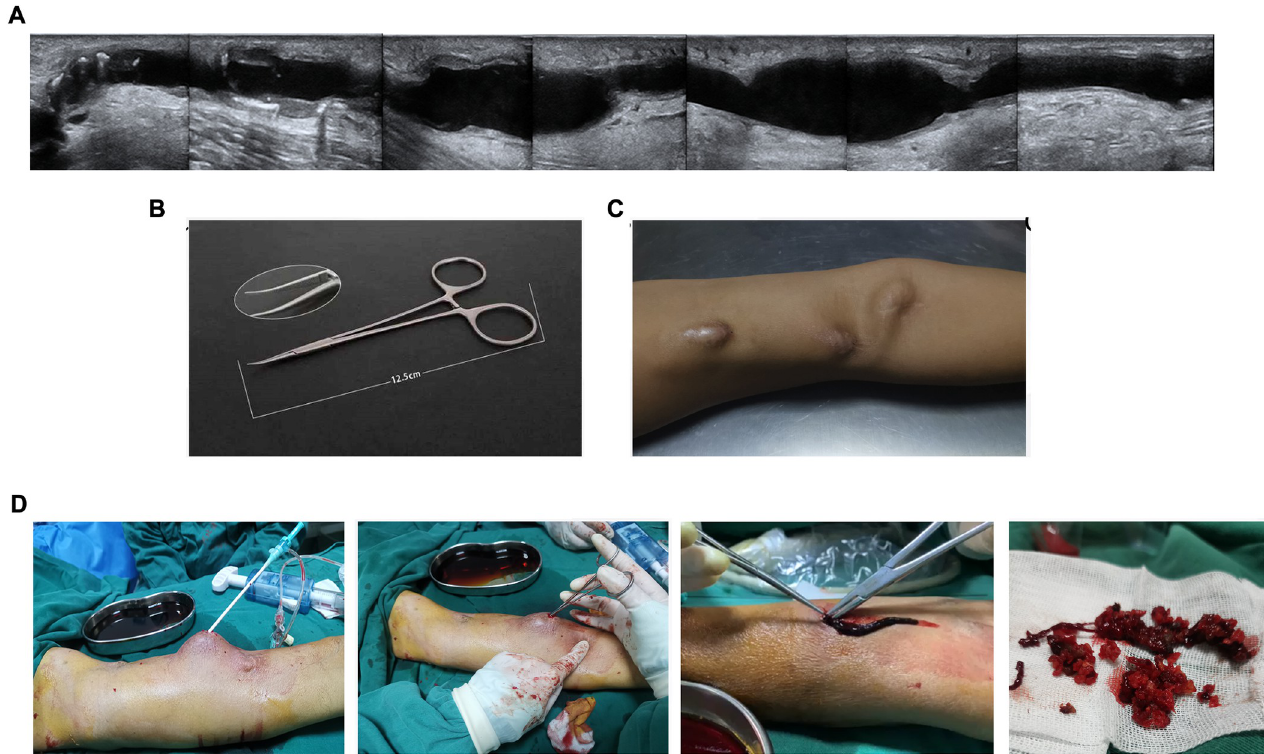
Fig 1. Representative case of scoop thrombectomy. (A) Ultrasound image demonstrating AVF thrombosis at the site of the anastomosis. (B) Mosquito hemostatic forceps were used in the procedure. (C) Aneurysmal dilatation. (D) Surgical procedure. During surgical exploration, the forceps were inserted into the hole of the separated fistula, and the thrombus was